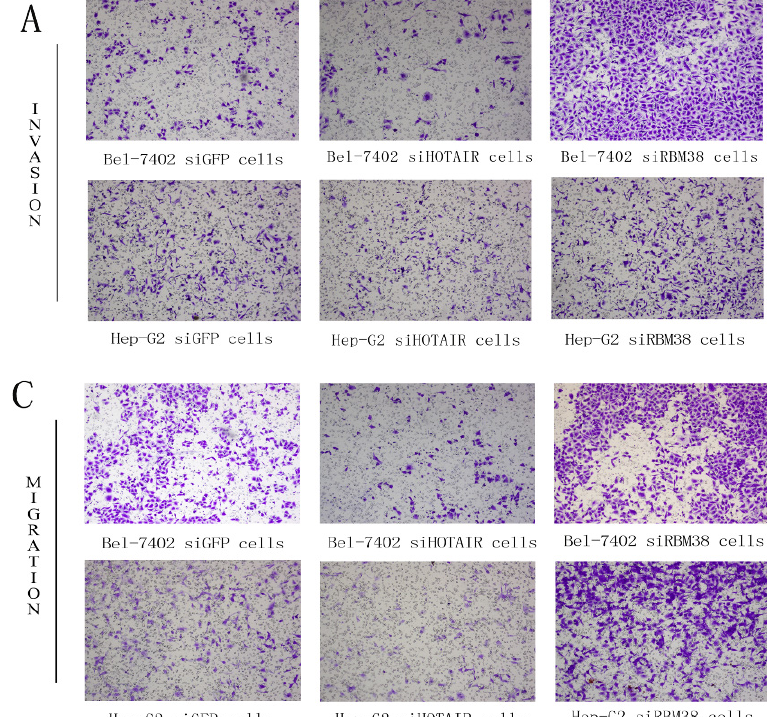
Figure 6. RBM38 inhibited the invasion and migration of HCC cells. Representative images of invasion ( A ) and migration ( C ) of Bel-7402 cells and HepG2 cells transfected with siGFP, siHOTAIR and siRBM38; The number of invaded cells was measured and represented in ( B ) and ( D ), respectively. The representative invasion images are shown at 100× magnification. * p < 0.05, ** p <